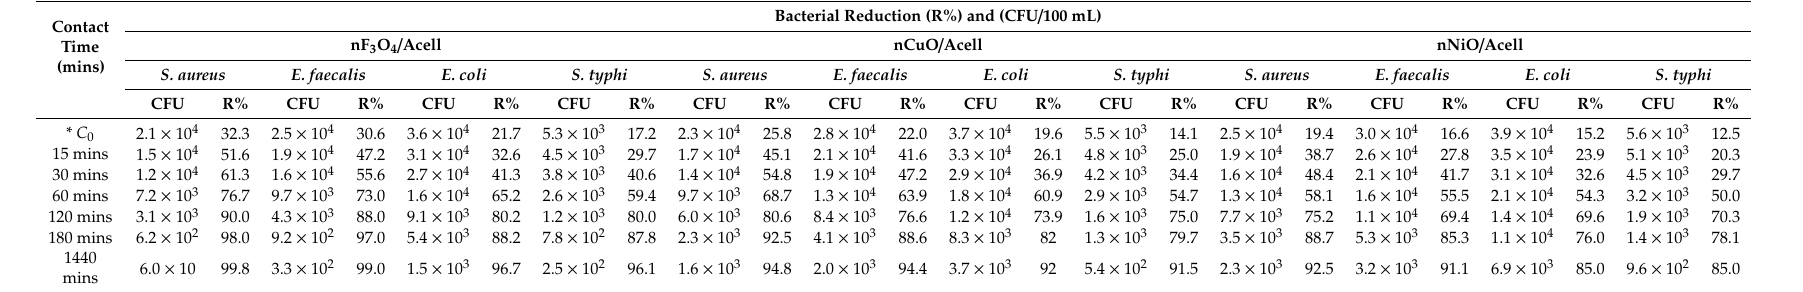
Table 2. E ff ect of contact time of the nMO / Acell nanocomposites on bacterial